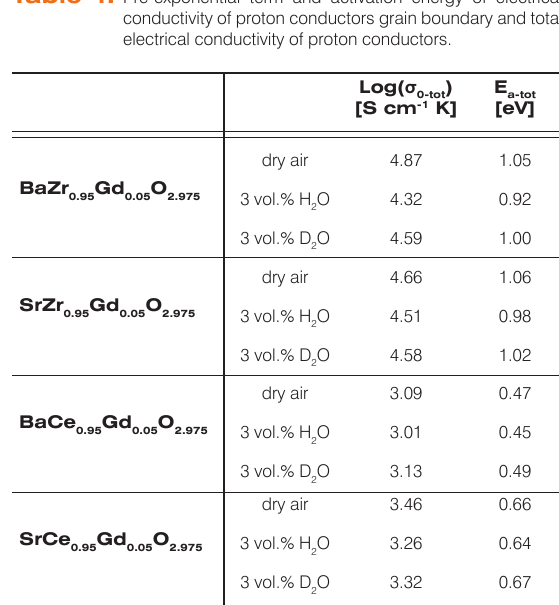
Figure 5. Total electrical conductivity values vs. temperature in atmosphere of humidified air. Values of activation energy and pre-exponential factor estimated from the least squares linear fit are given for each material spectra measured for BaZr (3 vol.% H O or D O) and dry air. 2 2 Table